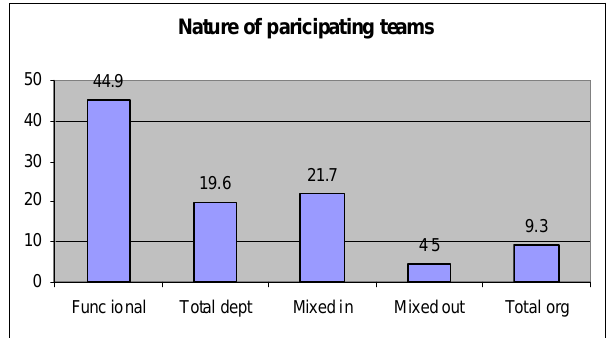
Figure 2: Nature of team Duration of intervention